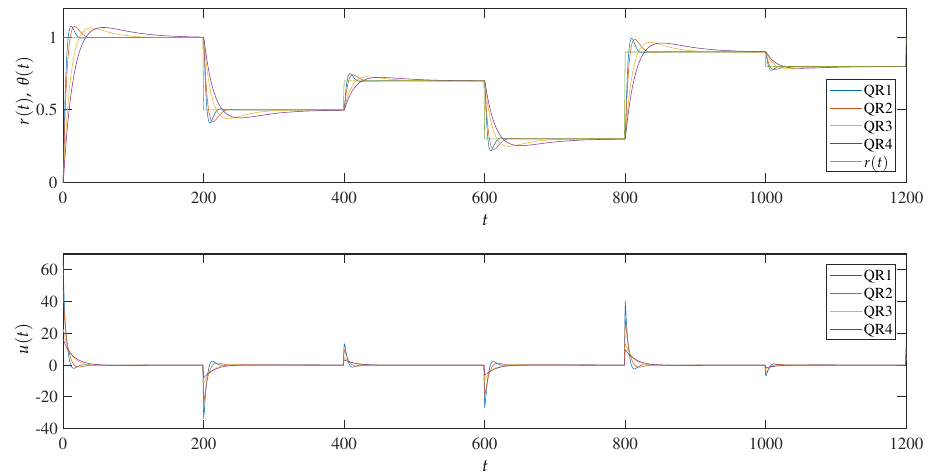
Figure 17. System response for different reference